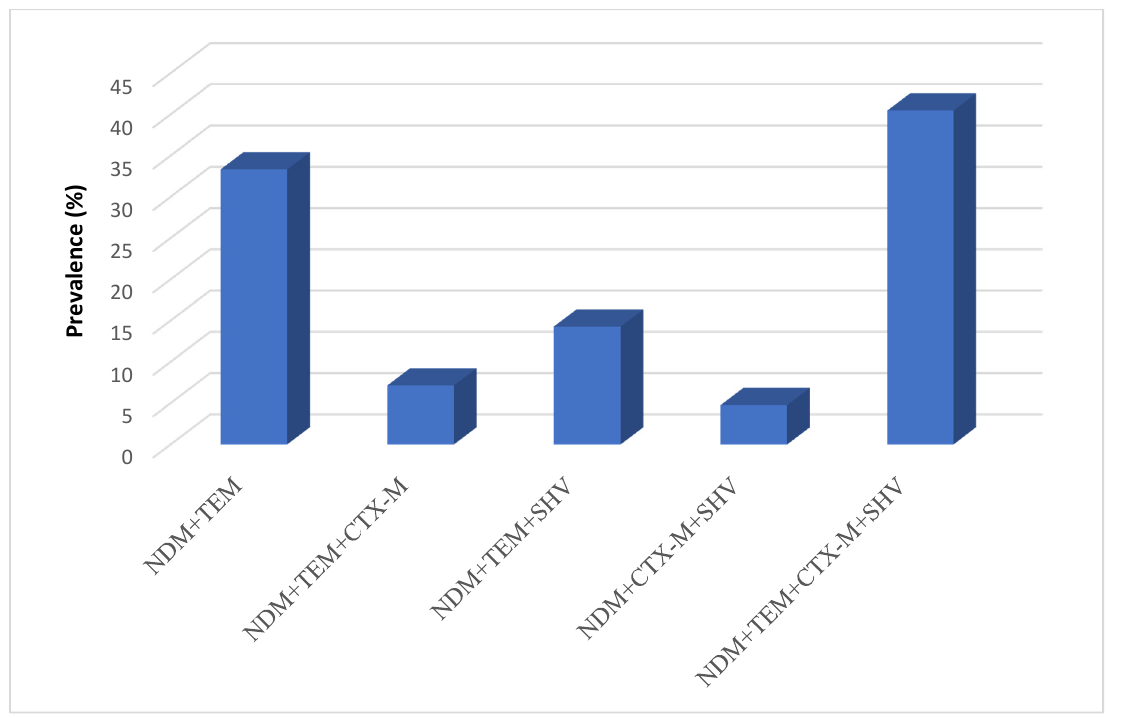
Figure 5. bla NDM association with class A ESBLs genes.